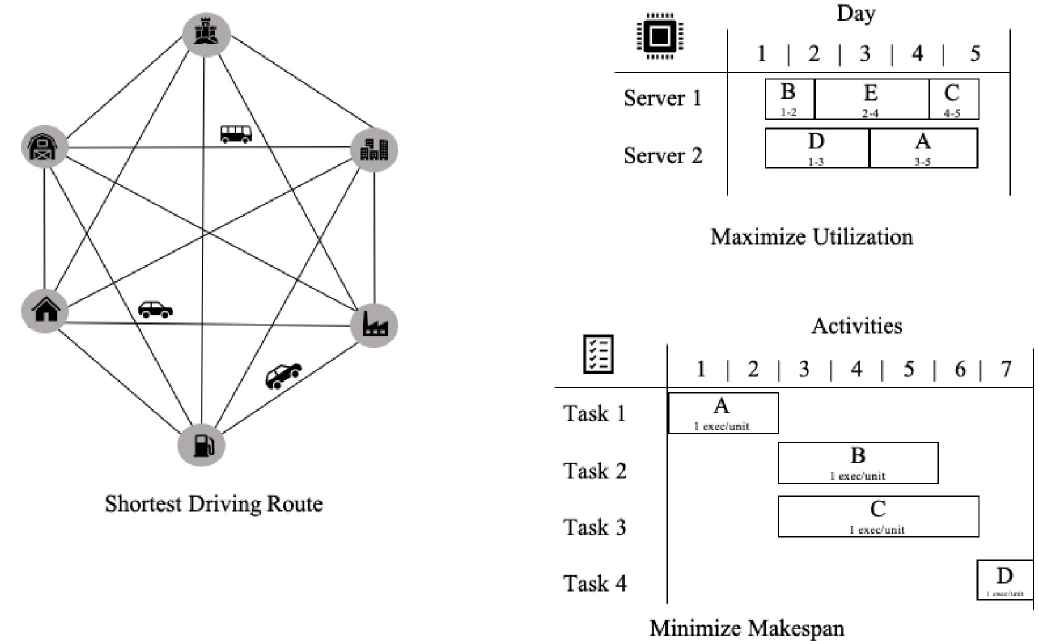
Fig 41. Example of TSP